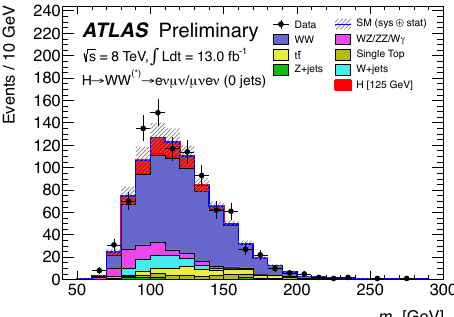
Figure 2. m T distribution in the signal region [5] in H + 0-jet analysis. The lepton flavours are combined. The expected signal for a SM Higgs boson with m H = 125 GeV is added on top of the estimated total background. The W + jets background is estimated ττ backgrounds are scaled from data and WW , top and Z / γ ∗ → to use the normalization derived from the corresponding control regions. The hashed area indicates the total uncertainty on the background prediction.